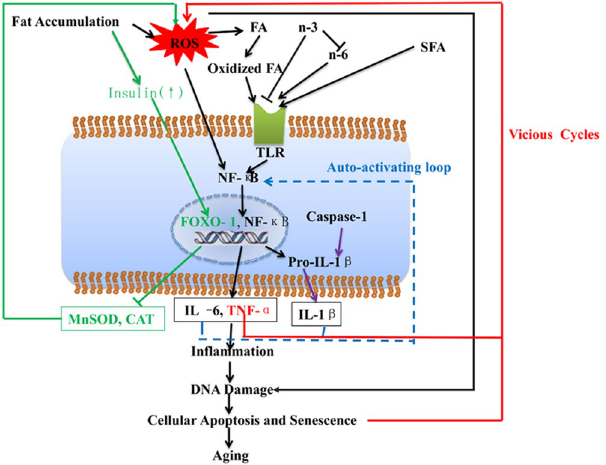
Figure 6. A proposed underlying mechanism for fat-induced oxidation/inflammation/aging. ROS, reactive oxygen species; FA: fatty acids; n-3: n-3 fatty acids; n-6: n-6 fatty acids; SFA: saturated fatty acid; TLR : toll- like receptor; NF- κ B: nuclear transcription factor κ B; FOXO 1: fork head box O 1; Pro-IL-1 β : pro-interleukin 1 β ; MnSOD: Mn superoxide dismutase; CAT: catalase; IL-6: interleukin 6; TNF- α : tumor necrosis factor α ; IL-1 β : interleukin 1 β ; purple line indicates the CASP-1 mediated pathway; green line indicates the insulin-induced pathway; red line indicates TNF- α , cellular apoptosis and senescence pathways which increase ROS production; blue dot line indicates auto-activation loop induced by IL-6 and IL-1 β